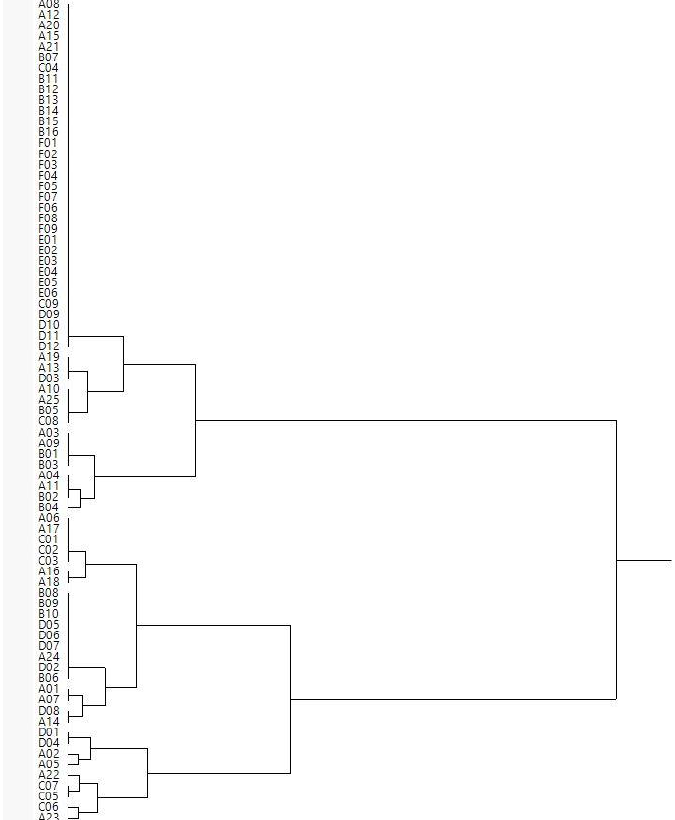
Figure 4. Dendrogram constructed using a hierarchical cluster analysis (Ward’s method) showing the relative similarities of restriction profiles obtained using three different restriction enzymes (AluI, HaeIII, and HinfI).